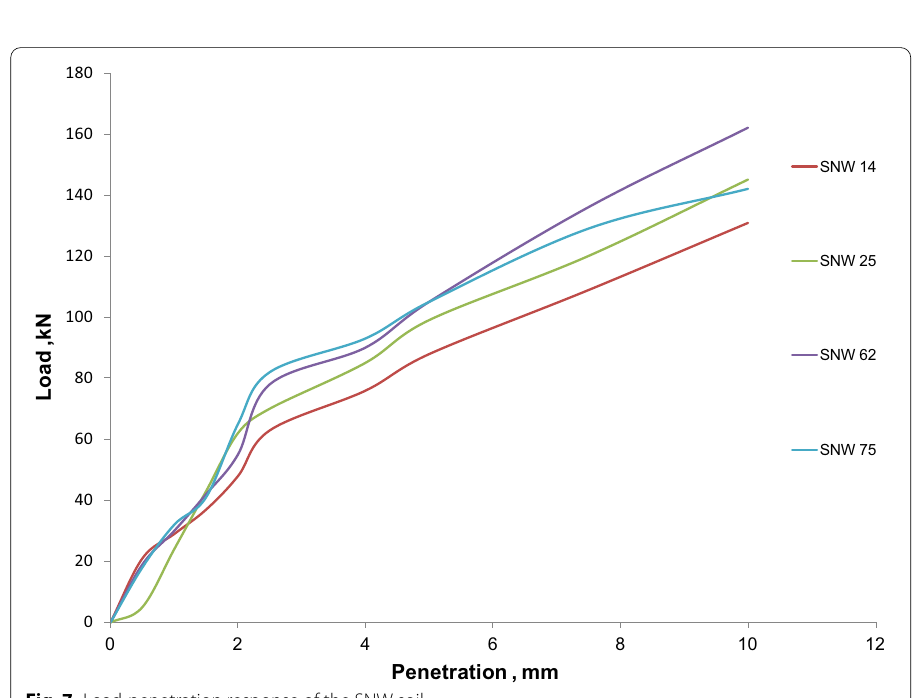
Fig. 7 Load-penetration response of the SNW